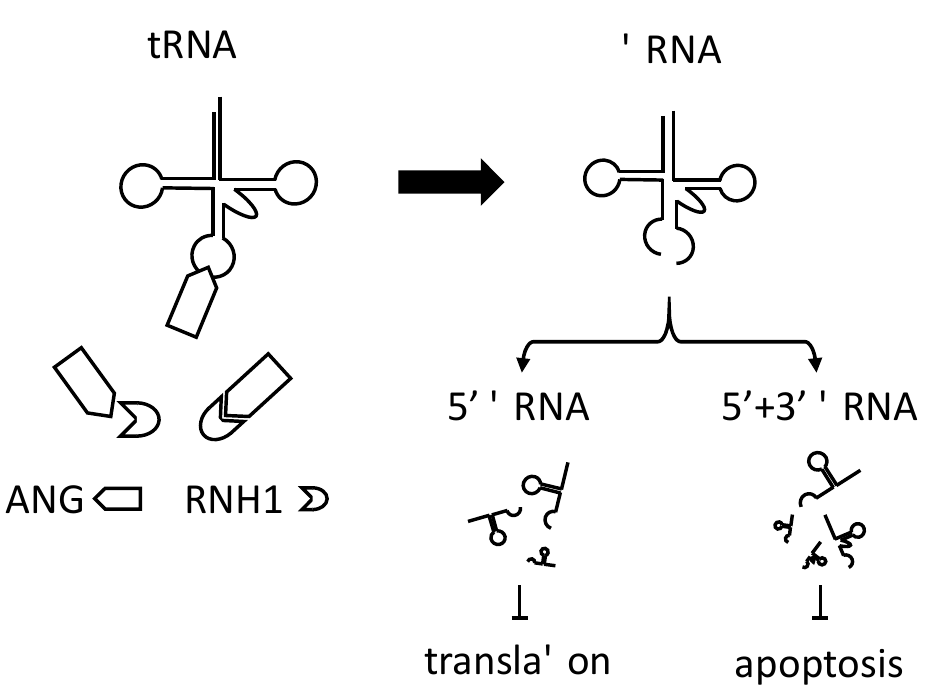
Figure 1. tiRNA production and behavior. Angiogenin (ANG) cleaves a tRNA to produce a tiRNA. ANG is suppressed by ribonuclease inhibitor 1 (RNH1); 5′ tiRNA, but not 3′ tiRNA, is effective in translation suppression. Both 5′ tiRNA and 3′ tiRNA are effective in suppressing apoptosis. Notably, transfection of tiRNA into cells augments stress granule (SG) formation [77,78]. SGs are cytoplasmic foci consisting of 40S ribosomal subunits, mRNA, translation initiation factors, and RNA-binding proteins. SGs promote cell survival in stressful environments by classifying and storing untranslated mRNAs, RNA-binding proteins, and signaling molecules [79–82]. Even if tiRNAs cause global translational repression, SG formation will allow cells to quickly return to their original translational levels after the stress has been relieved. As expected, treating cells with recombinant wild-type ANG, which can produce tiRNAs, promotes SG formation, but mutant ANG does not [77,78]. It should be noted that, like tRNAs [46–48], tiRNAs also inhibit apoptosome formation by binding cytochrome c and promote cell survival [83]. Thus, tRNA fragments regulate translation, SG assembly, and apoptosis (Figure